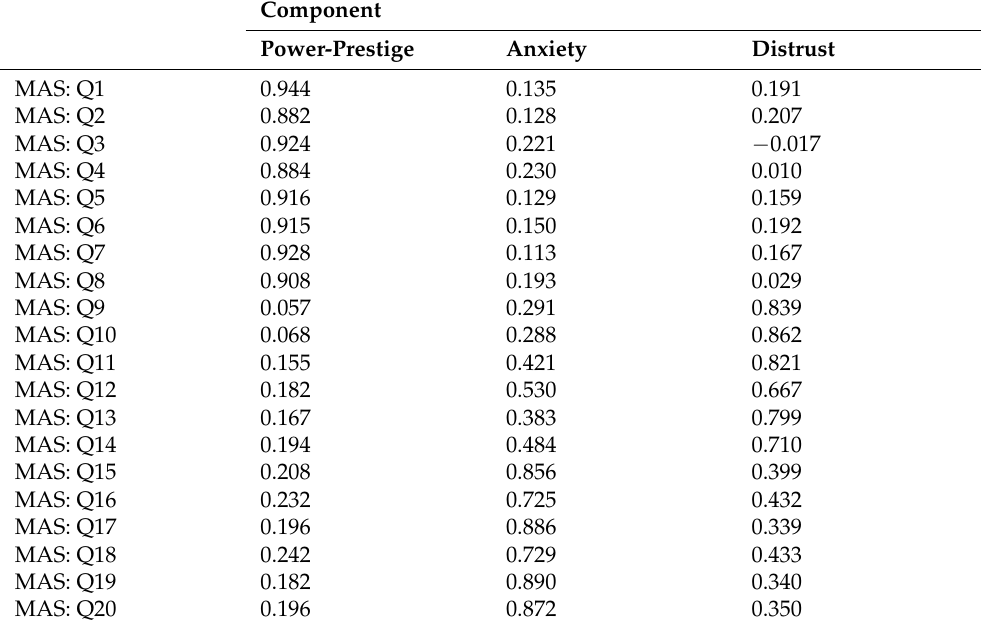
Table 2. Results of Exploratory Factor Analysis of Items on the Money Attitude Scale (MAS) (N =